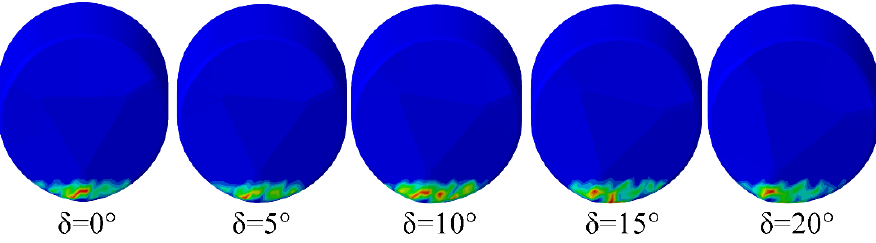
Figure 16. Contact stress distribution of 3-RDE cutter under different rotational angles.